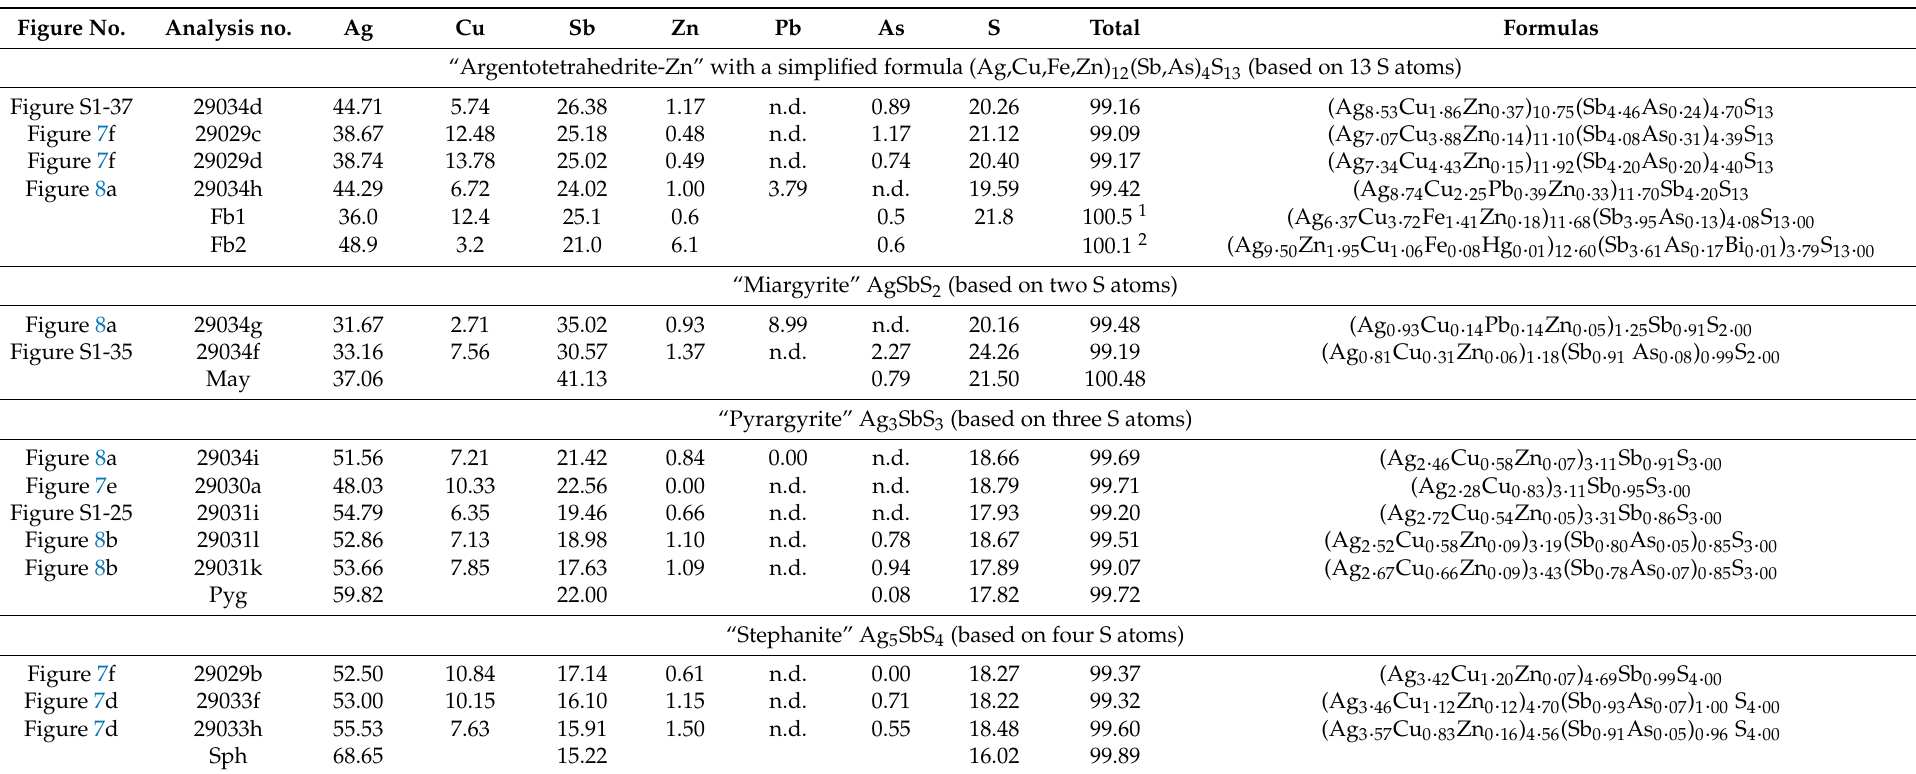
Fb (“freibergite” as a mineral species is now discredited [29]), May, Pyg and Sph are the “ideal” (and the closest for the studied grains) compositions of miargyrite (no. 1 from St. Andreasberg, Germany), freibergite (=argentotetrahedrite-Zn: Fb1 from Mt. Isa, Australia and Fb2 from Knappenstube mine, Austria), pyrargyrite (no. 1 from Sacarimb (Nagy á g), Romania) and stephanite (no. 1 from Copiap ó , Chile), respectively, from [30]. The mineral abbreviations are after [28]. 1,2, the analyses contain 4.1 and 0.2 wt% Fe, respectively; 2 , the analysis also contains 0.1 wt% Hg and 0.1 wt%